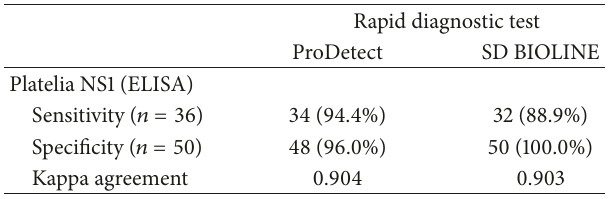
Table 1: Sensitivity, specificity, and kappa agreement of commercial RDTs for dengue NS1 detection in patient